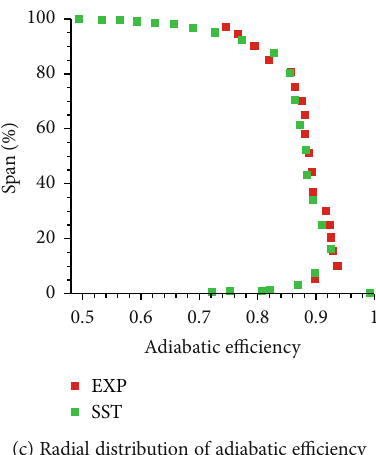
Figure 11: Computational and experimental spanwise distributions of total pressure ratio, total temperature ratio and adiabatic e ffi ciency at near-peak e ffi ciency condition.